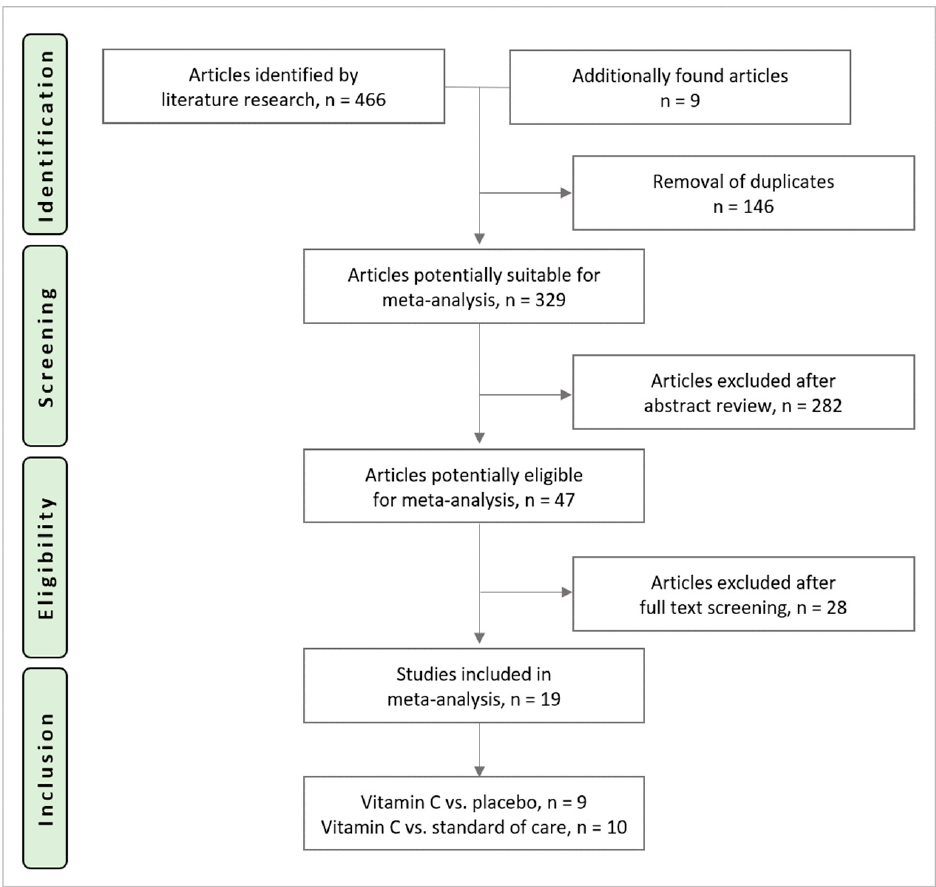
Figure 1. Study selection process.